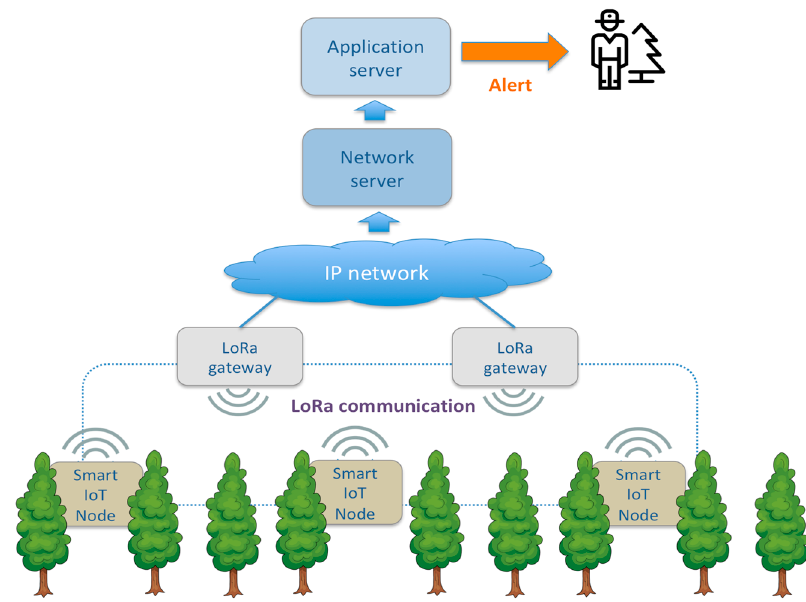
Figure 1. System